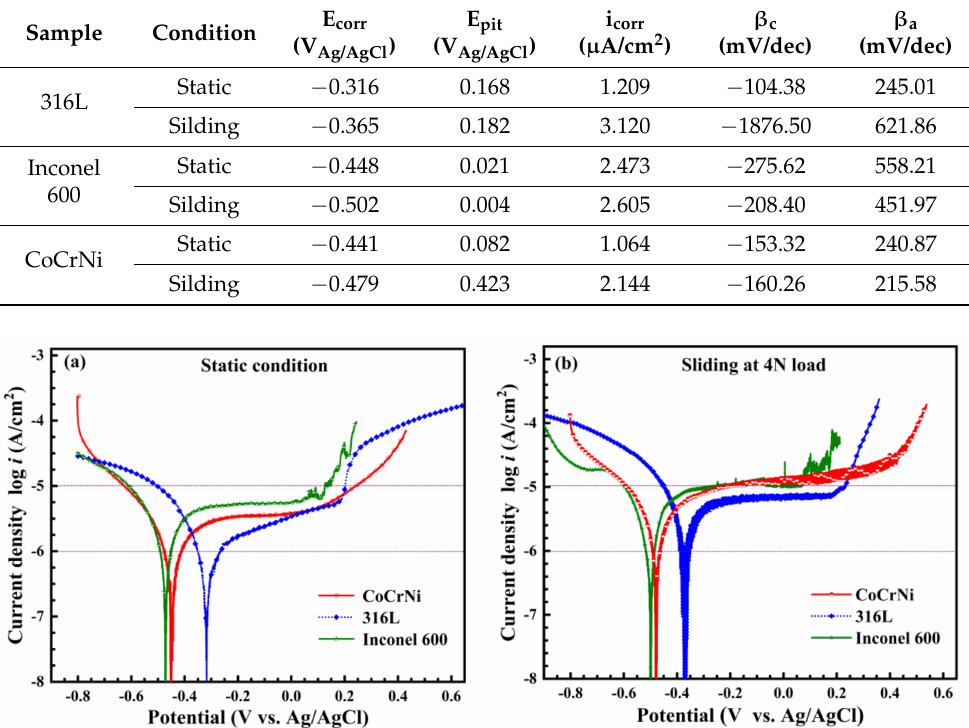
Figure 3. Potentiodynamic polarization curves of 316L stainless steel, Inconel 600, and CoCrNi rubbing against Si 3 N 4 in 3.5 wt.% NaCl solution under ( a ) static corrosion and ( b )